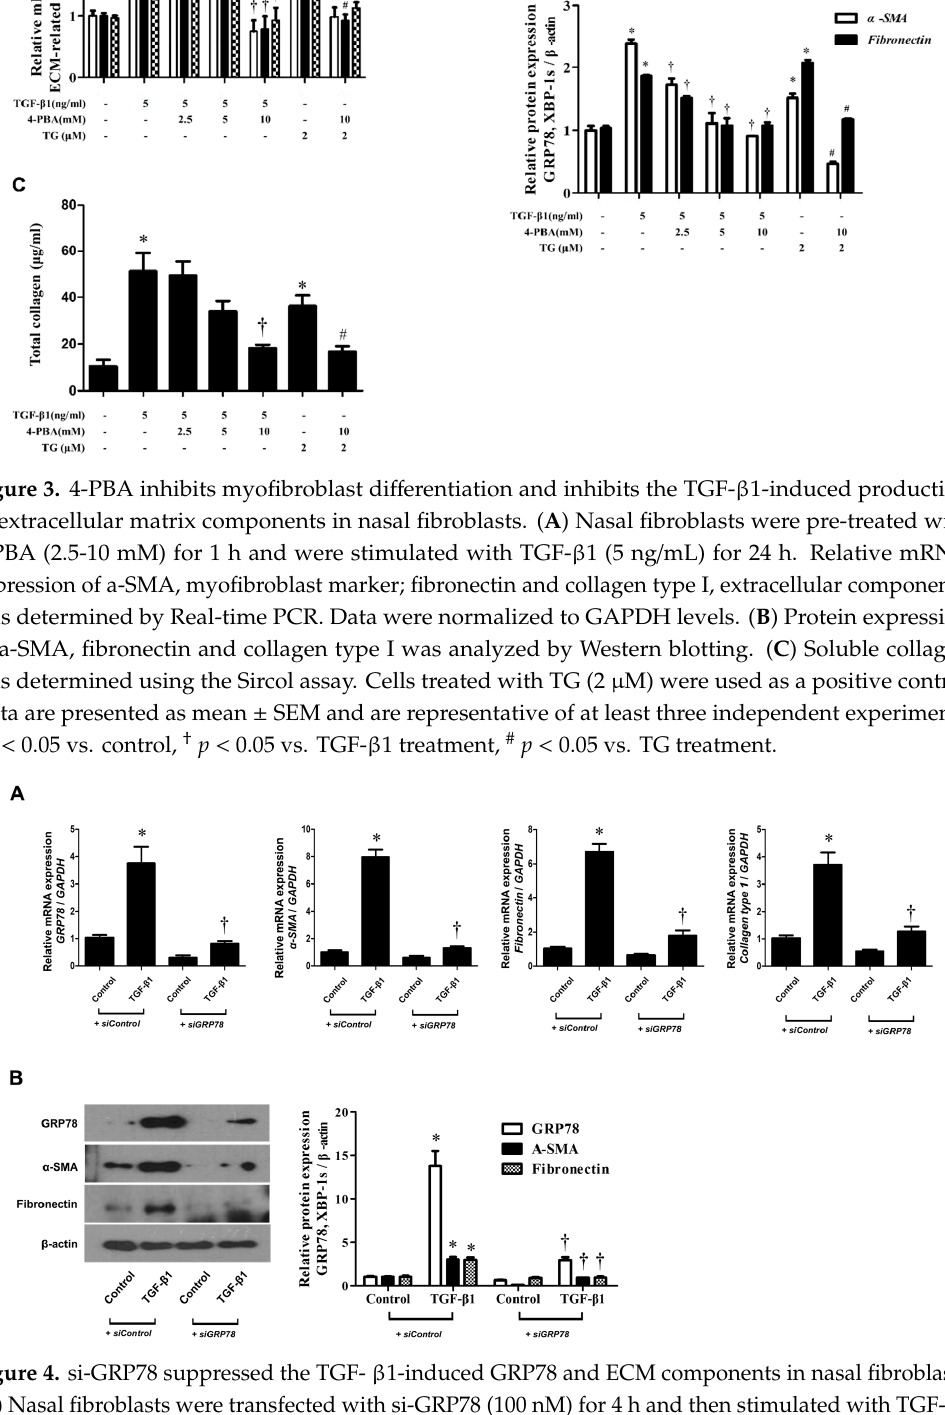
Figure 4. si-GRP78 suppressed the TGF- β 1-induced GRP78 and ECM components in nasal fibroblasts. ( A ) Nasal fibroblasts were transfected with si-GRP78 (100 nM) for 4 h and then stimulated with TGF- β 1 (5 ng/mL) for 24–72 h. The RNA levels of GRP78, α -SMA and fibronectin were determined by real-time PCR. ( B ) Protein expressions of GRP78, α -SMA and fibronectin were determined by Western blotting. Data are presented as mean ± SEM and are representative of at least three independent experiments. * p < 0.05 vs. si-control control, † p < 0.05 vs. si-control TGF- β 1 treatment.